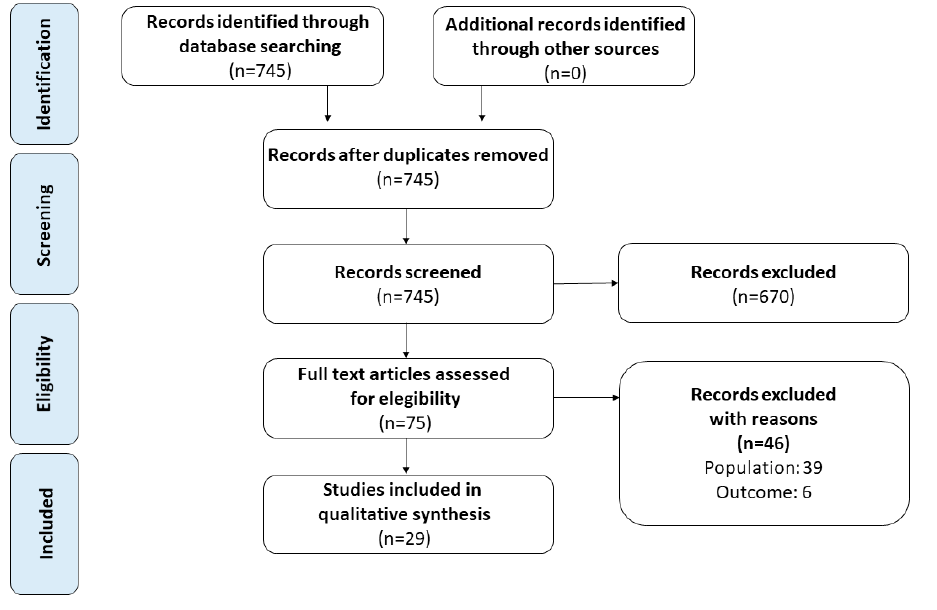
Figure 1. Flow diagram of the systematic review.